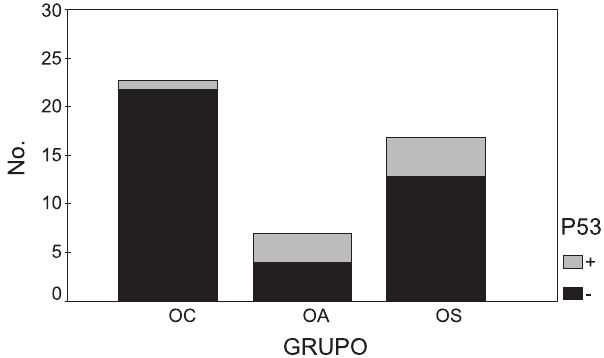
Figure 7 - Number of patients within the 3 groups classical osteoblastoma (CO), atypical osteoblastoma (AO), and osteosarcoma (OS), showing positive and negative immunoexpression for the p53 related with recurrence ( P = 0.009), atypical osteoblastoma classification ( P = 0.031), and with the presence of spicu- lated blue bone ( P = 0.018). Mutational changes of the p53 at exon 10 (codon 337) were identified in 3 of 4 patients with osteoblastoma (2 patients with atypical osteoblastoma, and 1 patient with classical osteoblastoma) (Figure 8) and 1of 4 patients with osteosarcoma. Exons 5 and 7 could not